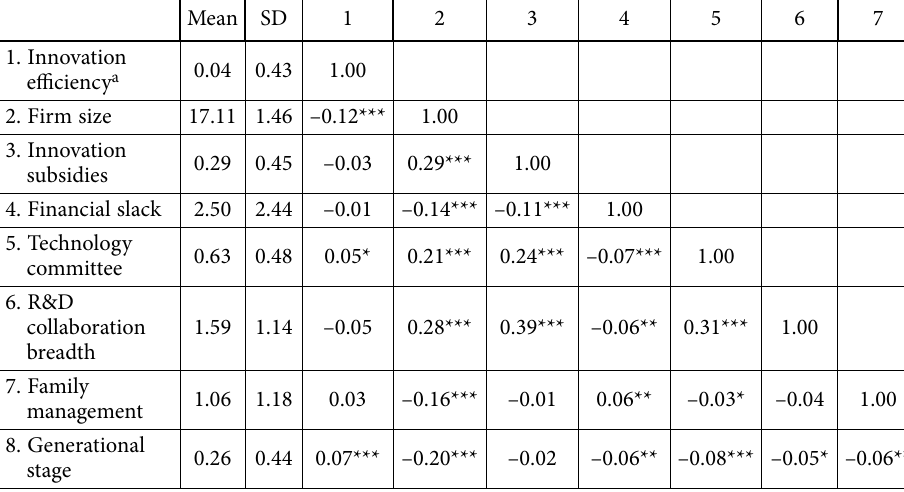
Table 2. Means, standard deviations and